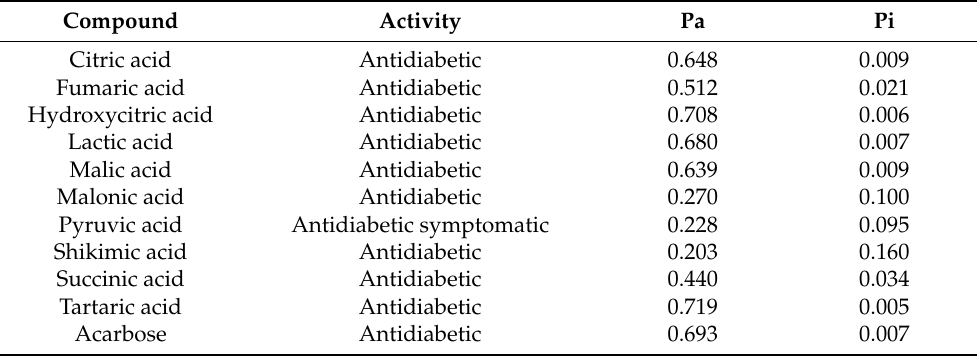
Table 9. Prediction of PASS result of RAMULAB54